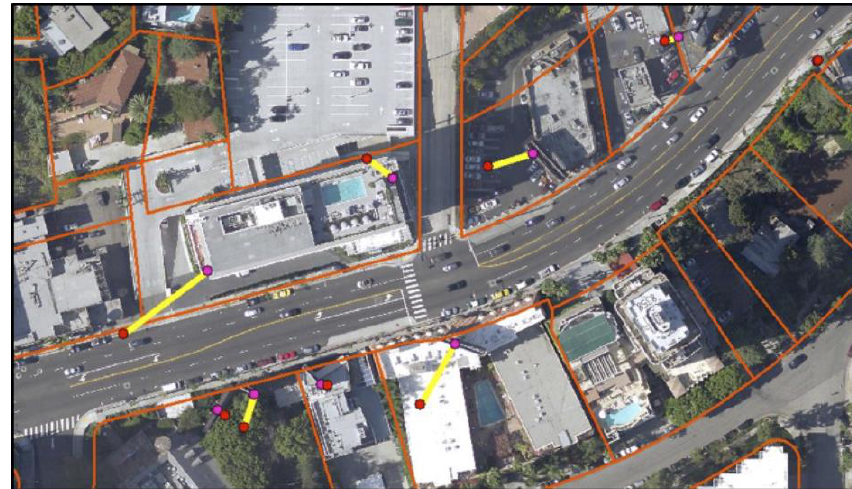
Figure 4. Sample image of ArcMap with line measurements between web and field data